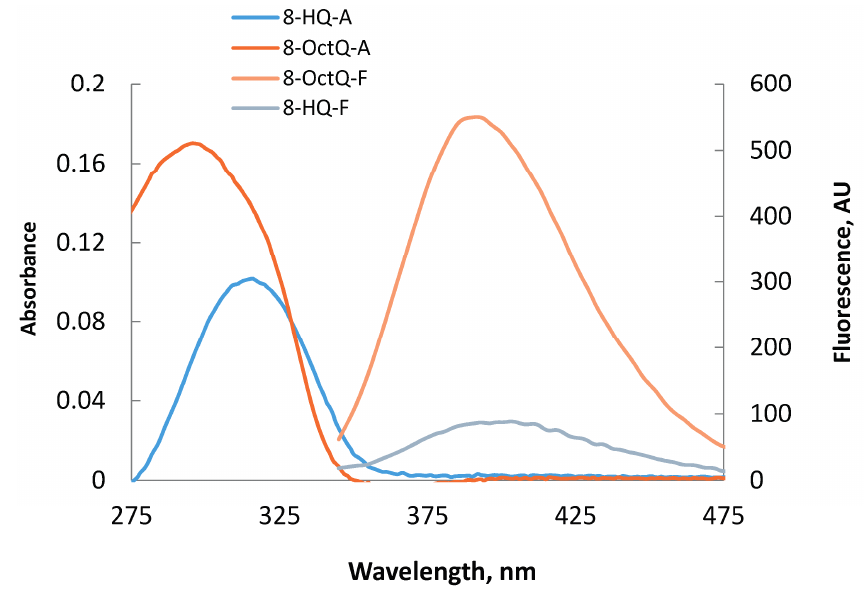
Figure 2. Absorption and fluorescence spectra of 8-HQ and 8-OctQ in acetonitrile solution (1 × 10 − 5